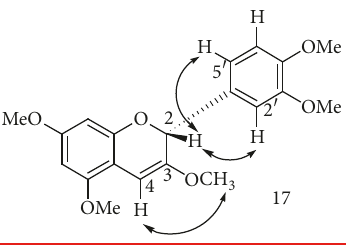
Scheme 5: Observed NOESY interactions between H-2 and H-2 󸀠